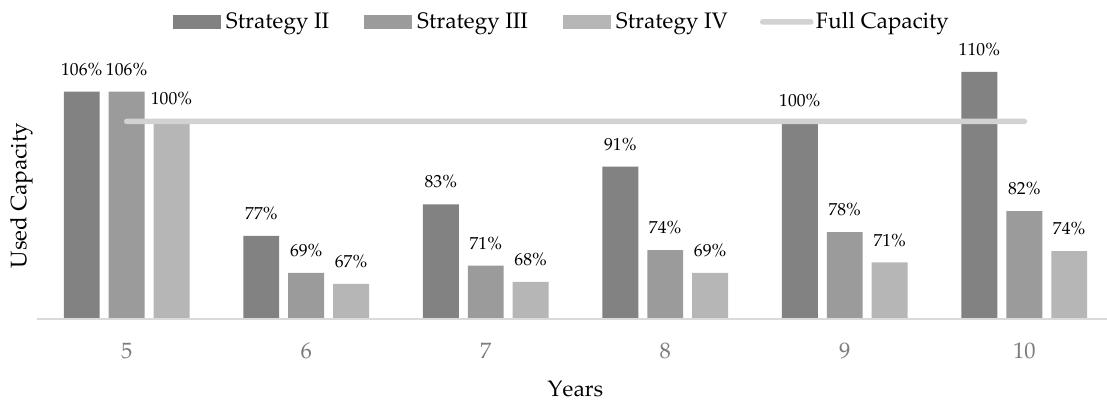
Figure 8. Effects of two kinds of overhaul strategies (II and III) on the maintenance, used capacity along the planning horizon.